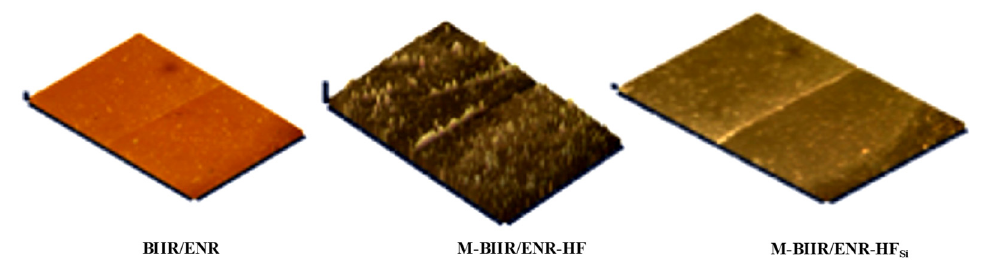
Figure 6. Morphologies of M-BIIR compounds mixed with ENR-CNT/CB composites for the unfilled and filled TESPT silane coupling agent after healing propagation.